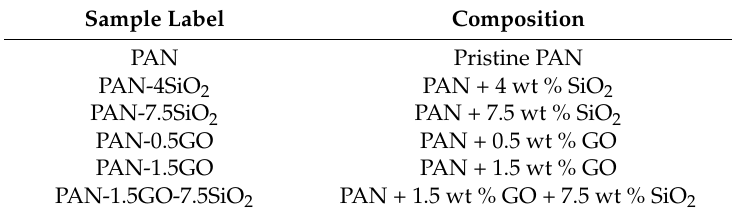
Table 1. Electrospinning compositions of composite and hybrid membrane.